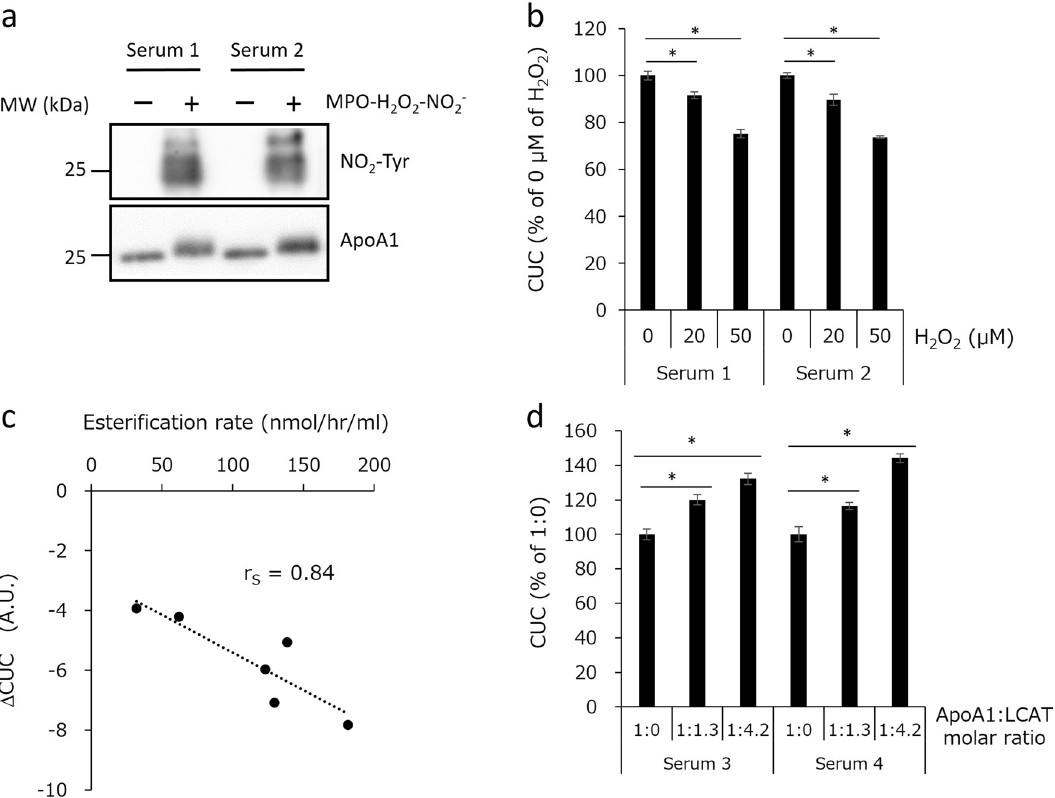
Figure 3. Impairment of CUC by the MPO-mediated oxidation of HDL or in the presence of LCAT inhibitor and its enhancement by the addition of recombinant LCAT. ( a ) Serum samples were oxidized with MPO–H 2 O 2 – NO 2− and analyzed by western blotting. Original uncropped western blot images are shown in Supplementary Fig. 5. ( b ) CUC of serum modified by MPO–H 2 O 2 –NO 2− . ( c ) CUC of serum samples in the presence or absence of NEM, and the difference between them was calculated as ΔCUC. Basal LCAT activities (esterification rate) of the same set of samples were also measured and compared with ΔCUC. ( d ) CUC of serum samples with low LCAT activity was assessed with or without recombinant LCAT protein. All values represent the means